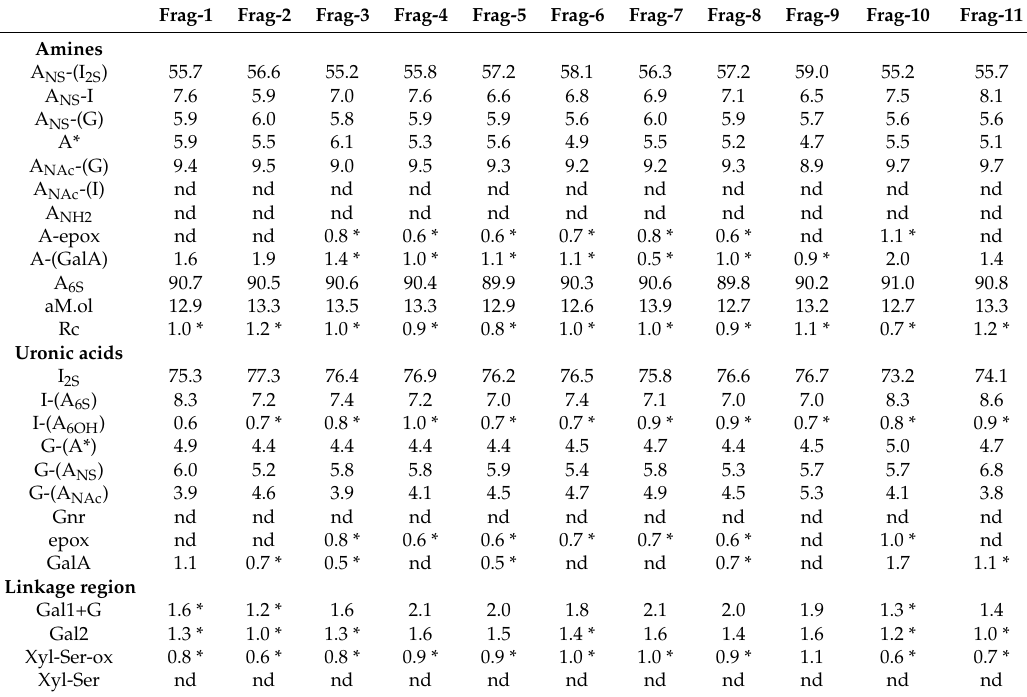
Table 1. Percent content of variously substituted glucosamine and uronic acid residues in different disaccharide sequences of Fragmin ® samples, together with typical linkage region